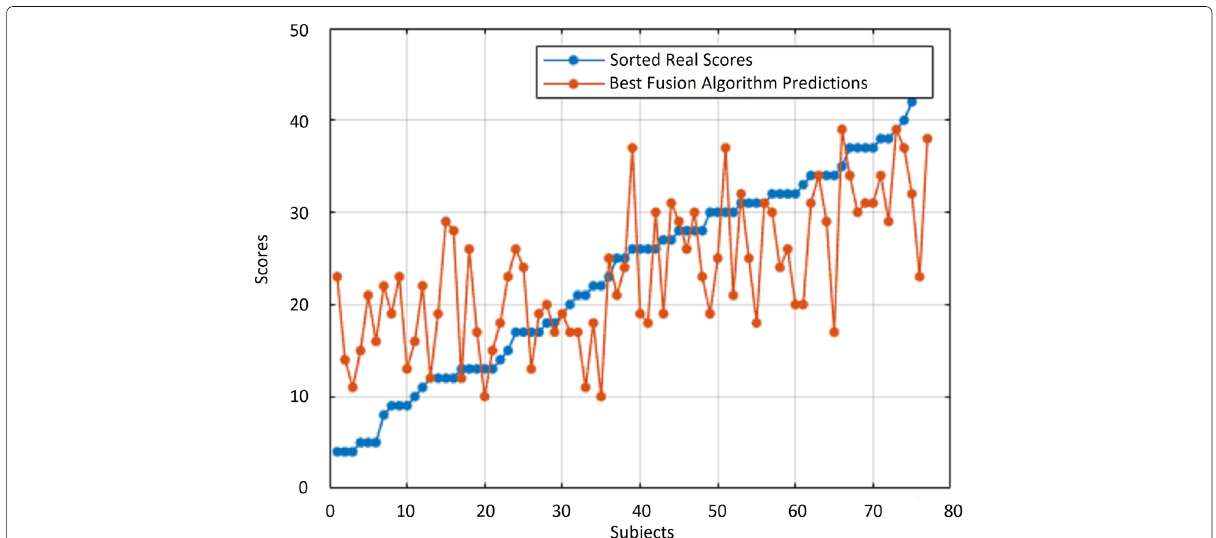
Fig. 7 Sorted real scores and predictions with the ml-MRMR ( N min = 3) are compared using the Turkish and English databases for the regression task with the Turkish dataset